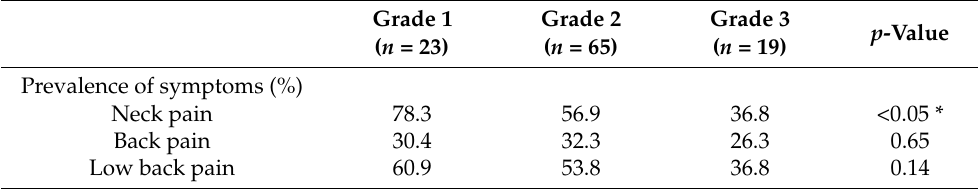
Table 3. Prevalence of symptoms in patients with cervical OPLL according to DISH grade.